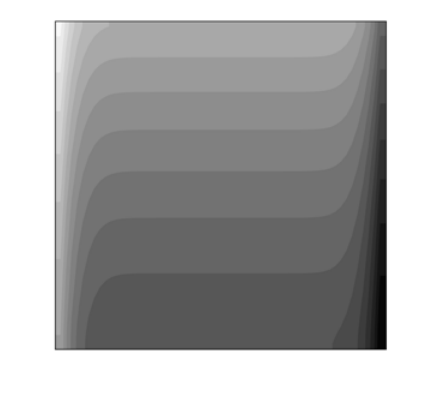
Fig. 6. The water saturation field.